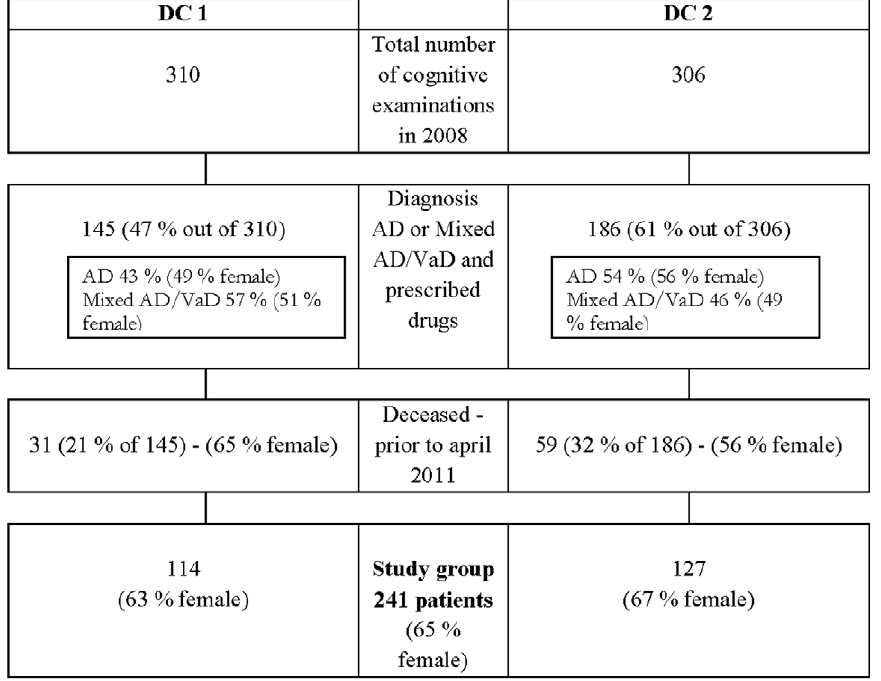
Figure 1. Flow chart describing the patients included in the study.